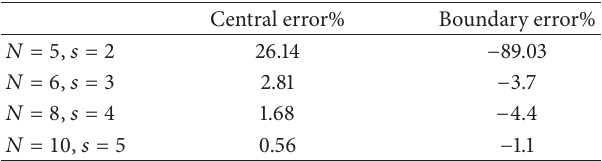
Table 3: Central ( 𝑥 = 0.5 ; 𝑦 = 0.5 ) and boundary ( 𝑥 = 0 ; 𝑦 = 0 ) error relative to maximum bending deflection of an SS-SS-SS-SS square plate of unit